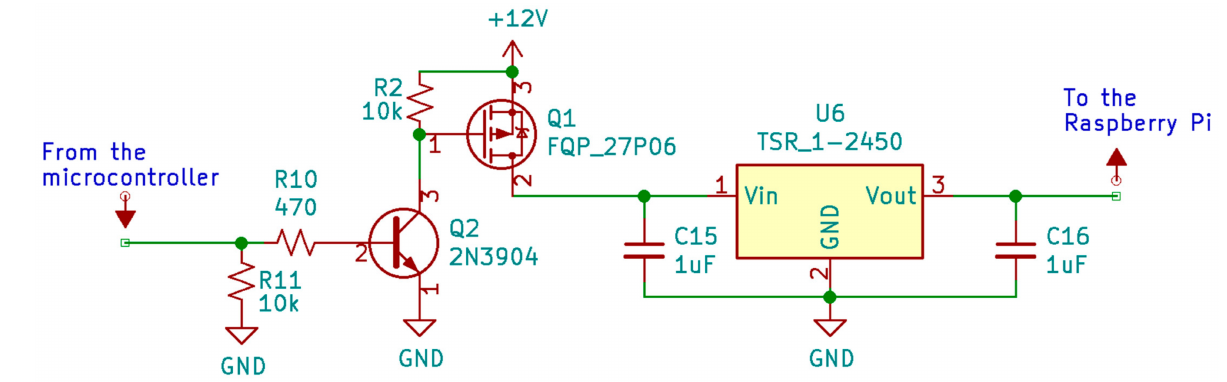
Figure 2. Power control circuit of the CIWS computational